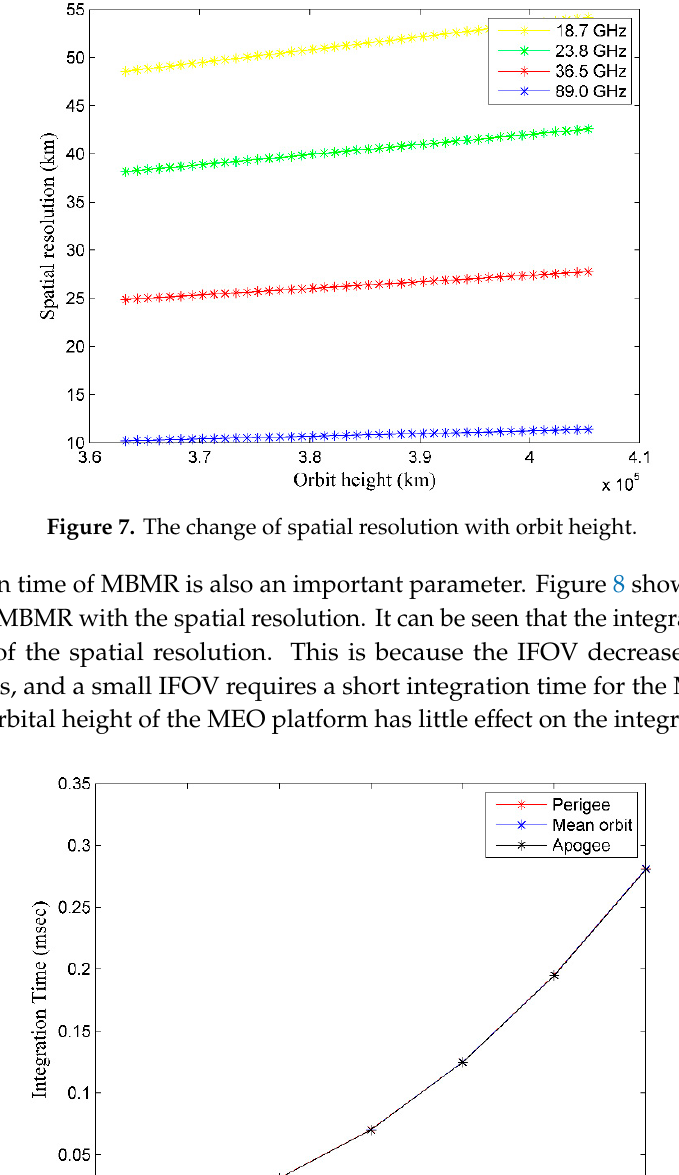
Figure 8. The change of the integration time of MBMR with spatial resolution.